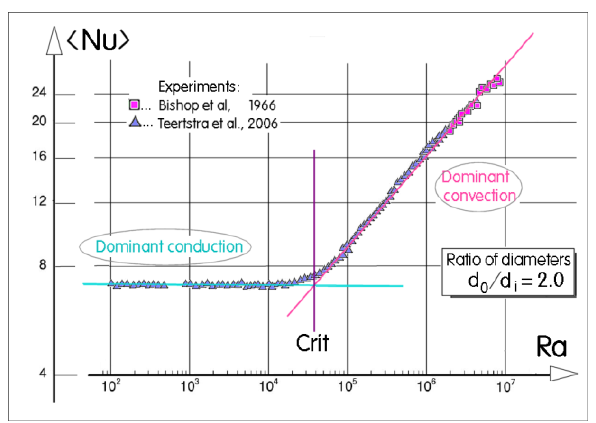
Fig. 9 Typical dependence of heat transfer intensity on Rayleigh number Ra in conditions existing in the space between concentric spheres – adapted from [4, 5]. The convective streaming driven by buoyancy is present at Ra above the nominal critical state Crit